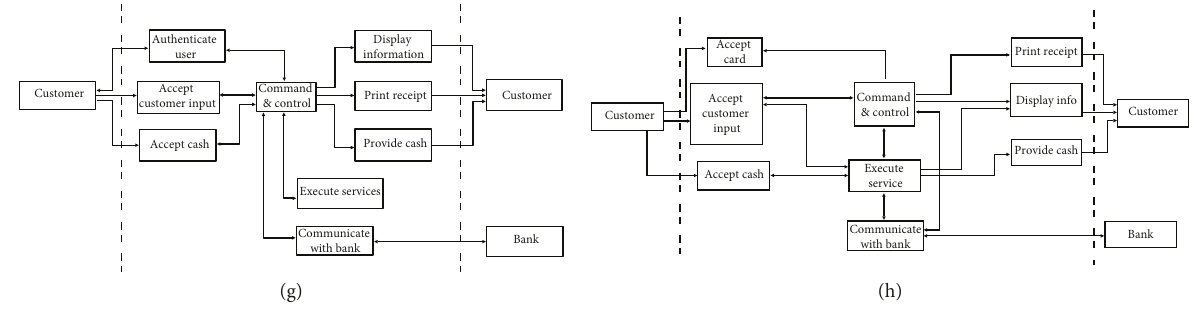
Figure 1: Examples of two architectures.